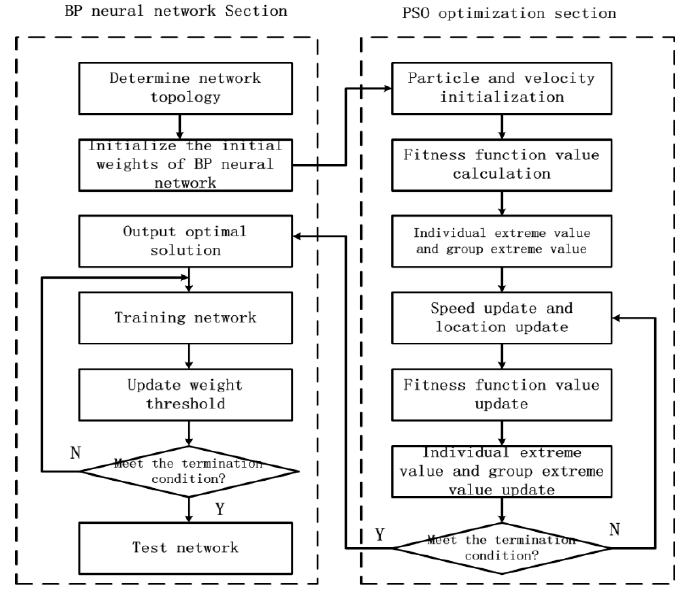
Figure 6. PSO (particle swarm optimization) optimization and BP neural network flowchart.